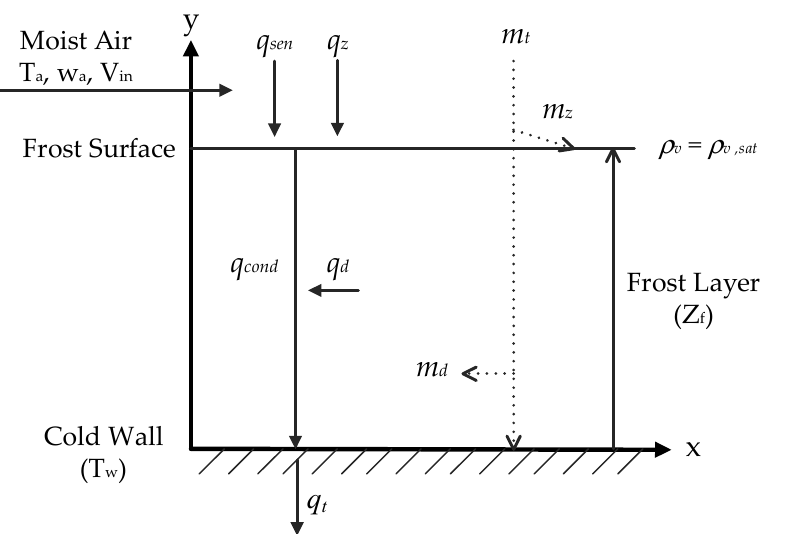
Figure 4. Schematic of the physical model and boundary conditions. Based on the aforementioned assumptions, the impact of the frosting phenomenon in association with heat and mass transfer can be quantified by the frost thickness and density. Upon simulation, the properties for each state may change with air temperature, absolute humidity, air velocity, and wall temperature. The proposed algorithm shown in Figure 5 is capable of predicting the relevant influence on frost growth. The calculation process for each time step can be separated into three parts, and the details for each part are described in the followings: